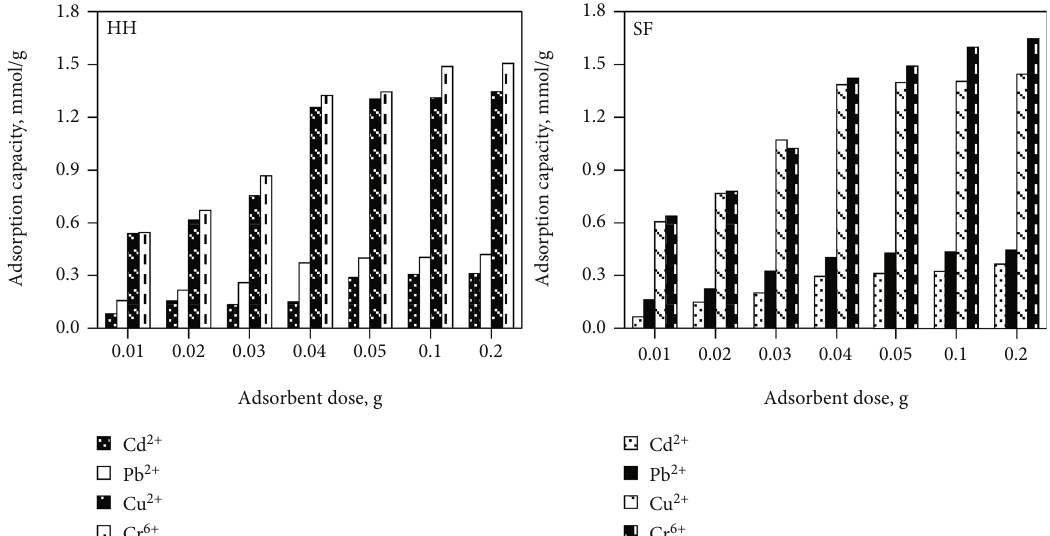
Figure 4: Adsorption of heavy metal ions at di ff erent biomaterial doses using (a) HH and (b) SF. Experimental conditions: 298K and pH